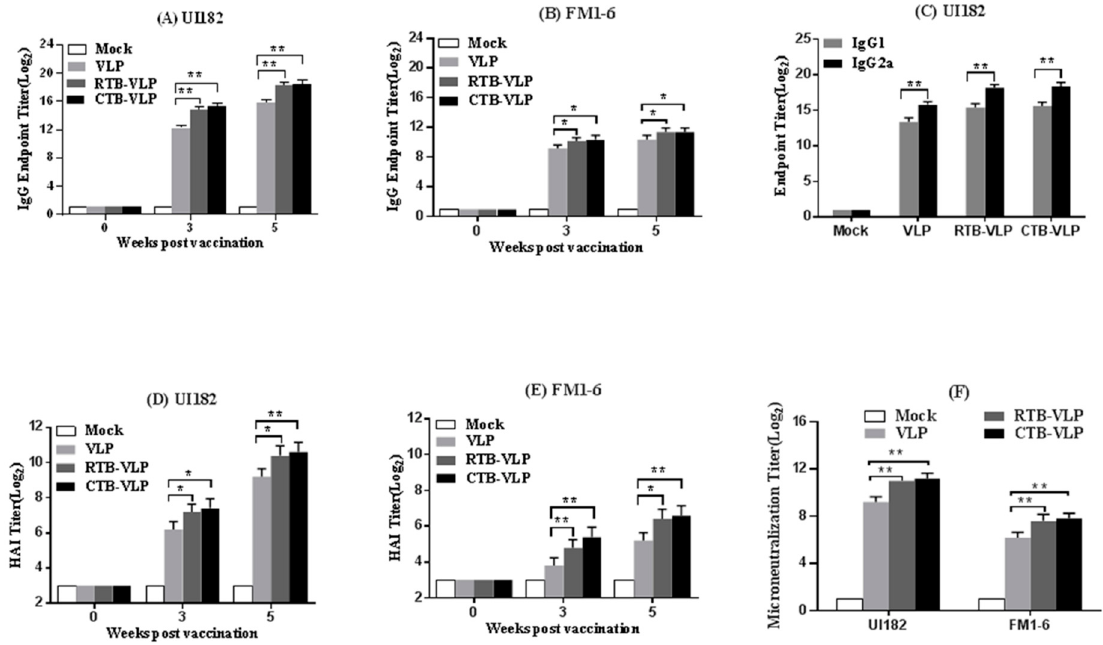
Figure 2. Intranasal immunization with cVLPs enhances systemic antibody responses. ( A , B ) Titers of serum IgG specific for UI182 virus ( panel A ) and FM1-6 virus ( panel B ) measured by indirect ELISA; ( C ) Titers of serum IgG1 and IgG2a specific for UI182 virus measured by indirect ELISA; ( D , E ) HAI titers against UI182 ( panel D ) and FM1-6 virus ( panel E ); ( F ) Virus-neutralizing antibody titers against UI182 and FM1-6 virus were determined for sera collected at week 5 post-vaccination. Data are shown as the means ± SD (n = 5). * p < 0.05, ** p < 0.01.